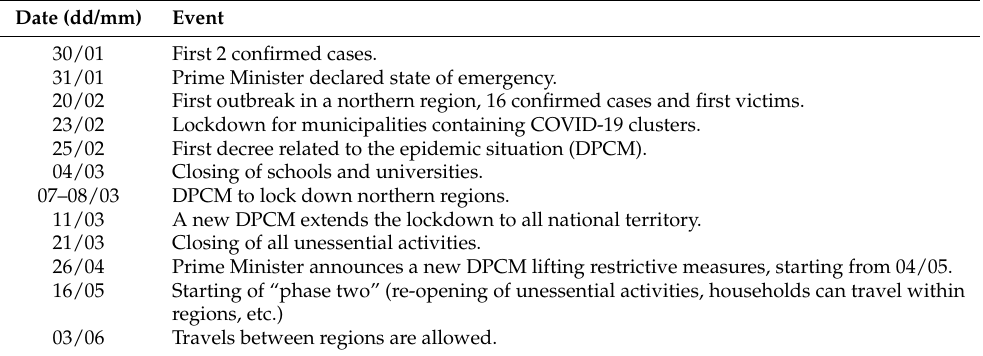
Table 4. Events and policies timeline related to the COVID-19 epidemic situation in Italy.